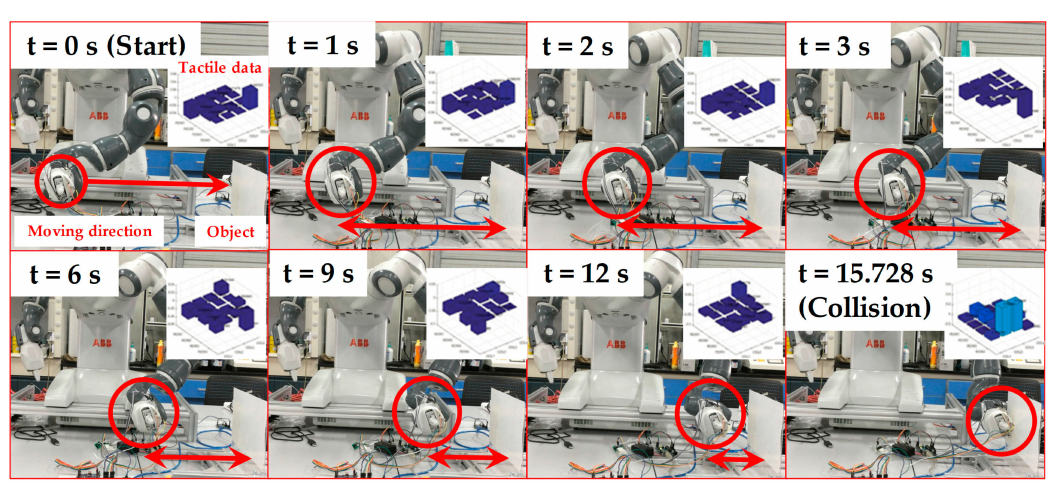
Figure 11. The integration test for safe and natural human–robot collaboration.